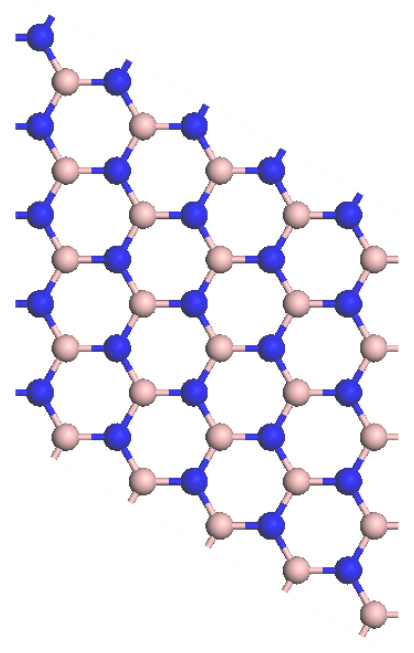
Figure 1. Intrinsic h-BN model.